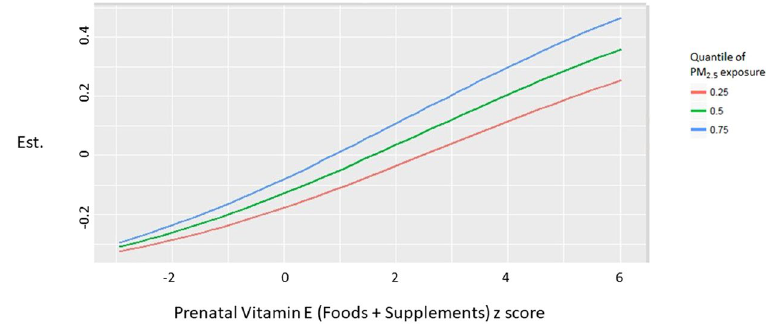
Figure 3. Prenatal Vitamin E Intake (Foods + Supplements) may interact with PM 2.5 Exposure to increase FeNO levels in adolescence. In subjects with elevated prenatal exposure to PM 2.5 , prenatal Vitamin E shows a stronger association with FENO in adolescence.